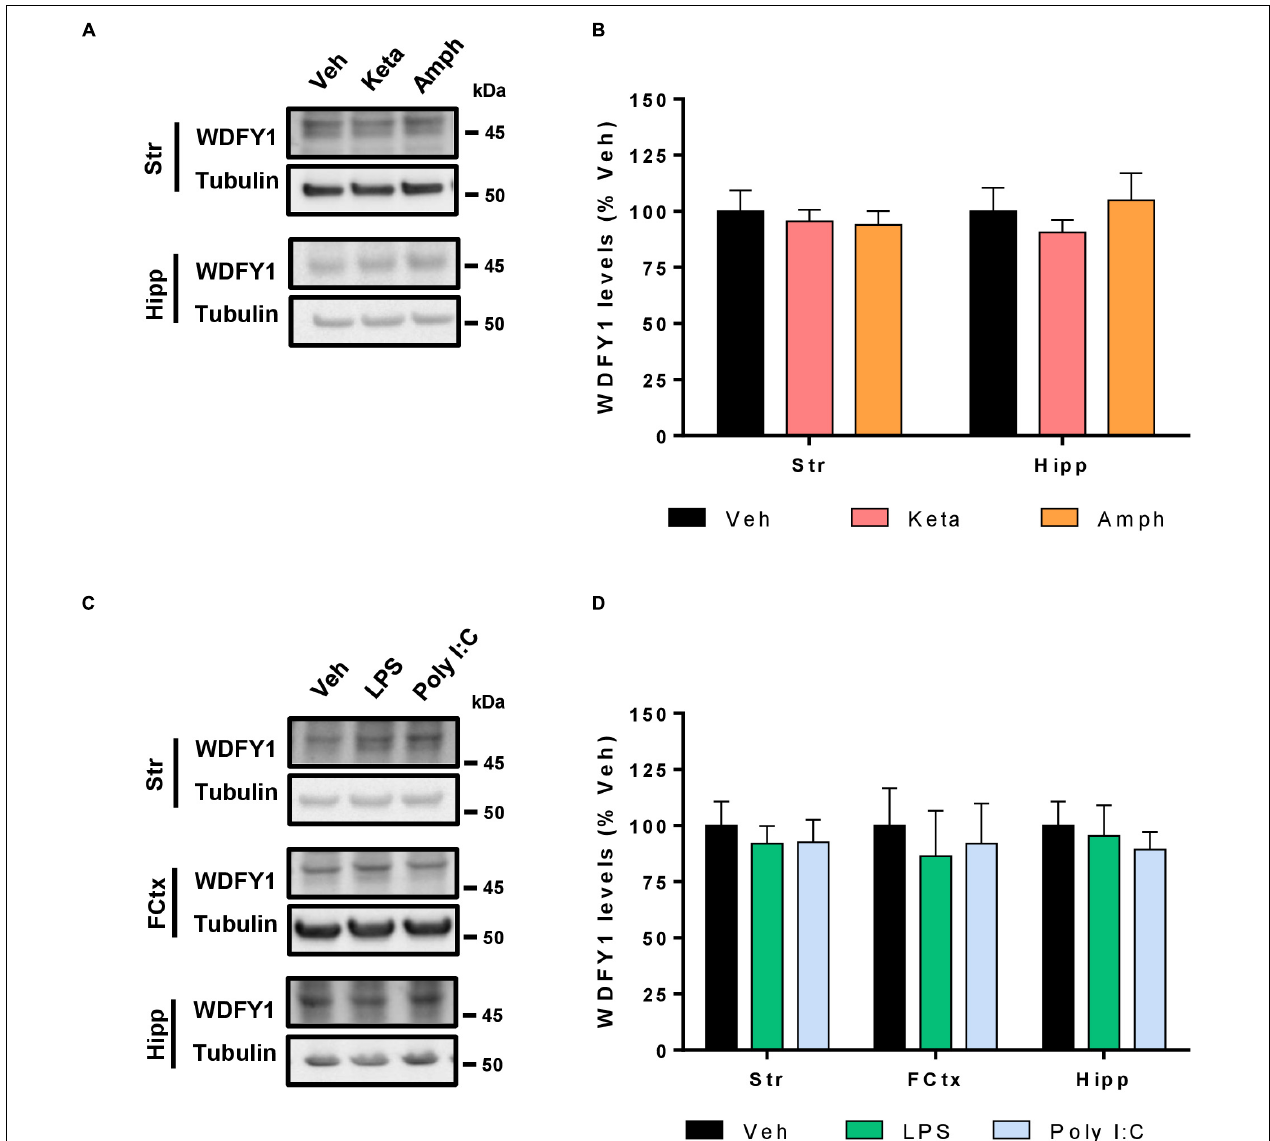
FIGURE 6 | WDFY1 protein levels in pharmacological models of schizophrenia. (A) Immunoblotting for WDFY1 and Tubulin as a loading control in the striatum (Str) and hippocampus (Hipp) of 10-week-old C57BL/6 mice treated with vehicle or amphetamine (3 mg/kg) or ketamine (30 mg/kg) for 8 days ( n = 8 vehicle- (Veh), 10 ketamine- (Keta) and 11 amphetamine-treated (Amph) mice). (B) Densitometry quantification of results as in (A) . Data were normalized to tubulin for each sample and expressed as percentage of wild type. (C) Immunoblotting for WDFY1 and Tubulin as a loading control in the striatum (Str), frontal cortex (FCtx) and hippocampus (Hipp) of C57BL/6 mice treated at postnatal day 5 with vehicle or LPS (6 mg/kg) or Poly I:C (6 mg/kg) and samples collected 24 h later ( n = 9 vehicle- (Veh), 6 LPS- and 7 Poly I:C-treated mice). (D) Densitometry quantification of results as in (C) . Data were normalized to tubulin for each sample and expressed as percentage of wild type. Bars represent mean ± SEM. Data were analyzed by one-way ANOVA and the Tukey’s test as a post hoc test in all panels.